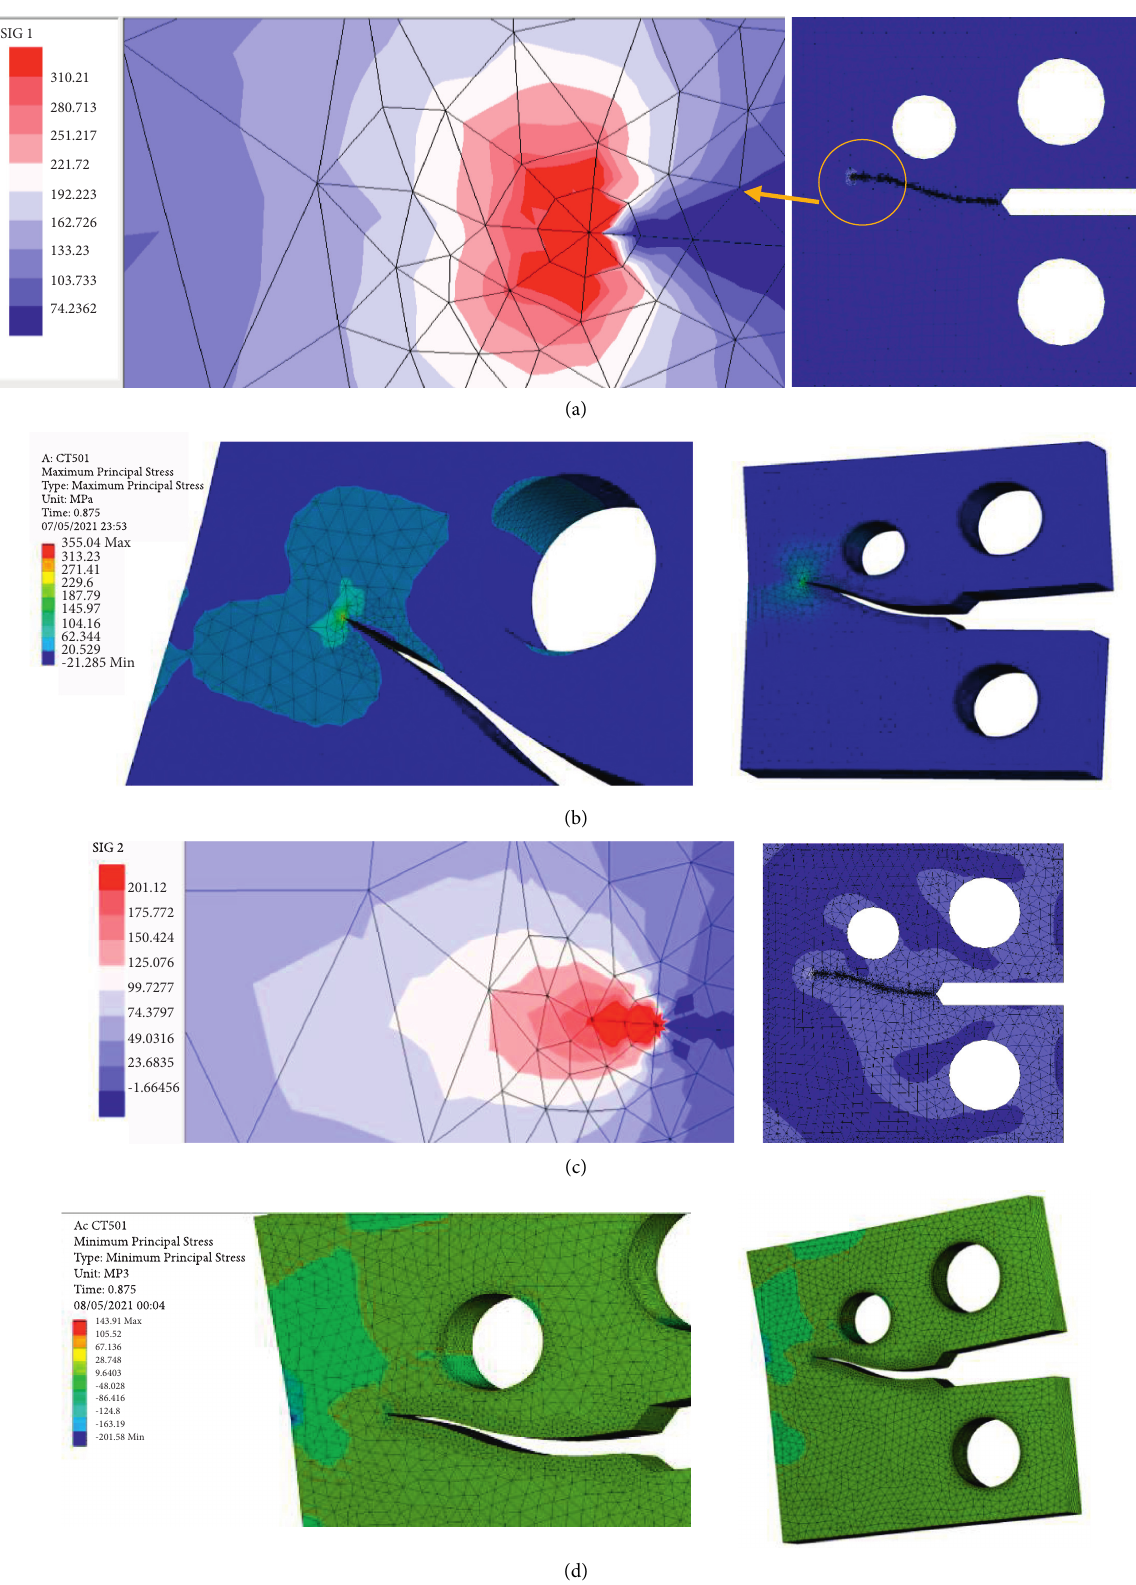
Figure 9: For CT01 specimen, (a) FRANC2D/L, maximum principal stress, (b) ANSYS, maximum principal stress, (c) FRANC2D/L, minimum principal stress, and (d) ANSYS, minimum principal